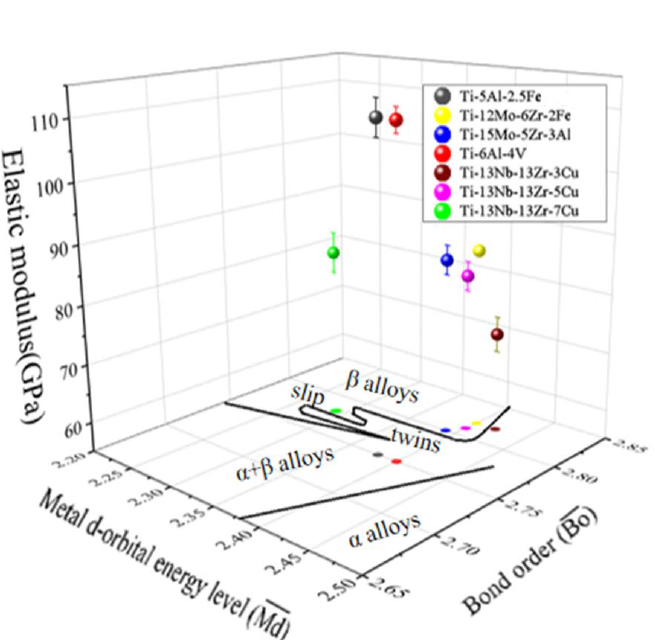
Figure 1. Three-dimensional diagram of ( Bo )-( Md ) and elastic modulus trend prediction of titanium alloy[10, 13, 14].